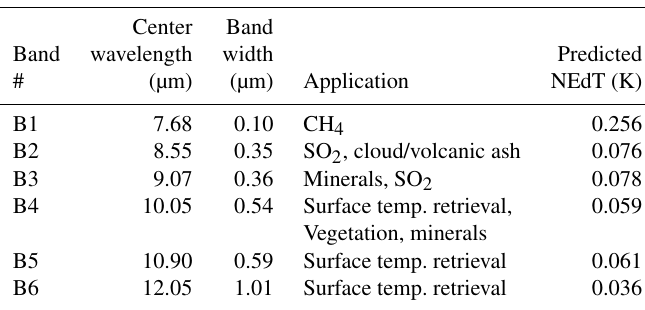
Table 1. MURI band allocations and predicted noise-equivalent delta temperature. Center Band Band